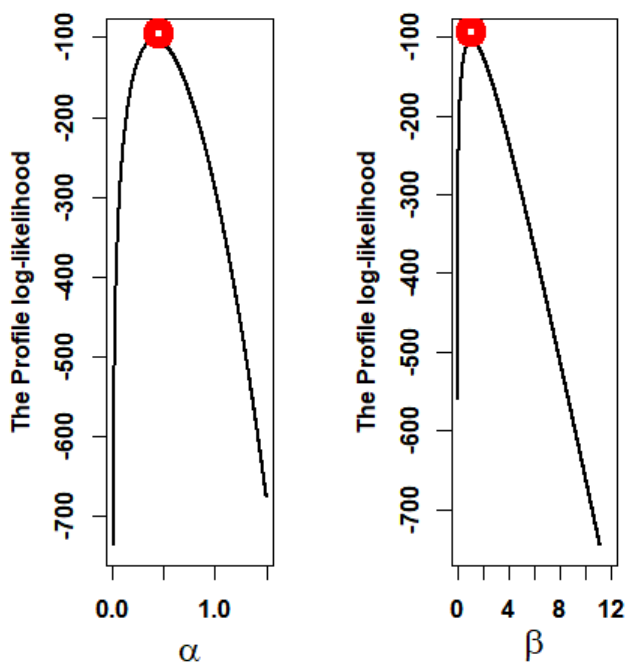
Figure 3. The profile log-likelihood plot for the first data set.